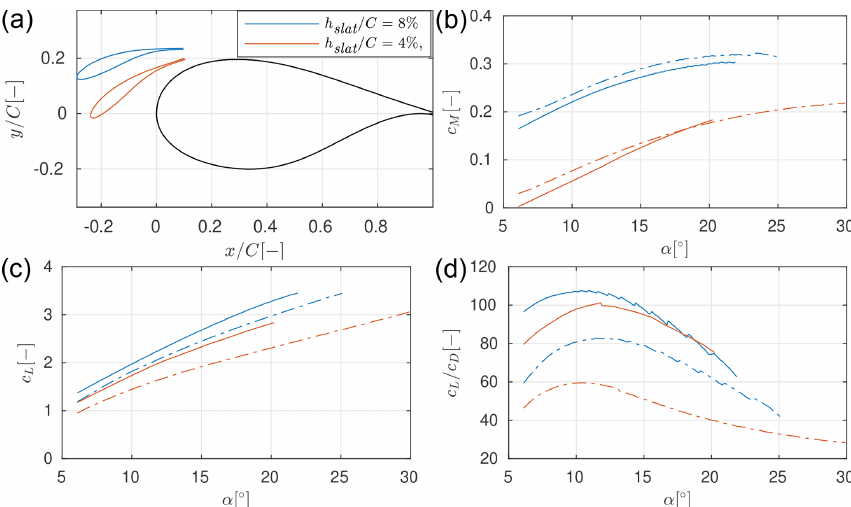
Figure 6. Results of slat position and dimension optimization as estimated with MSES for the clean ( − ) and the rough ( − . ) profiles in terms of (a) geometry, (b) lift, (c) drag, and (d) pitching moment.